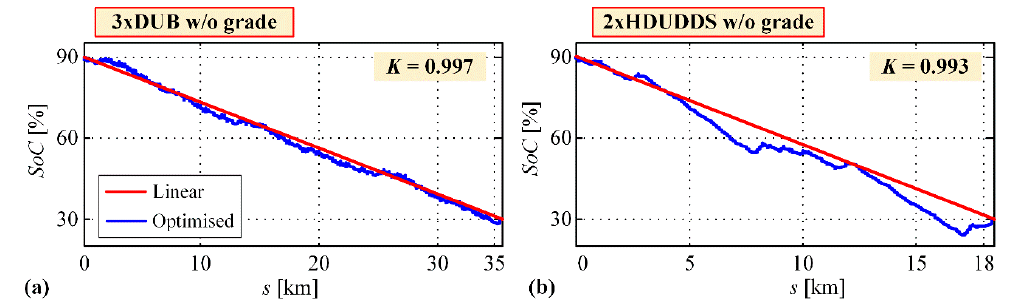
Figure 7. ( a ) Optimal SoC trajectories obtained by DP optimization and corresponding shortest-length (linear) trajectories for 3xDUB driving cycle and ( b ) 2xHDUDDS driving cycle and for zero road grade and no LEZ presence.